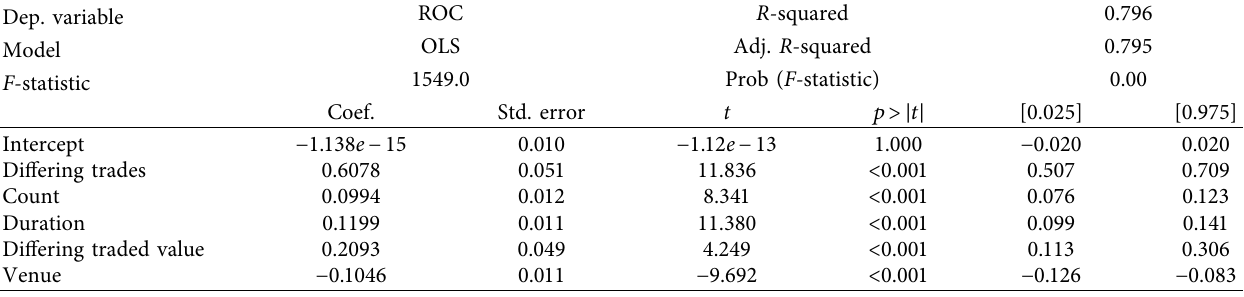
Table 4: Linear regression diagnostics for realized opportunity cost as a function of trade statistics, dislocation statistics, and venue fluctuation.